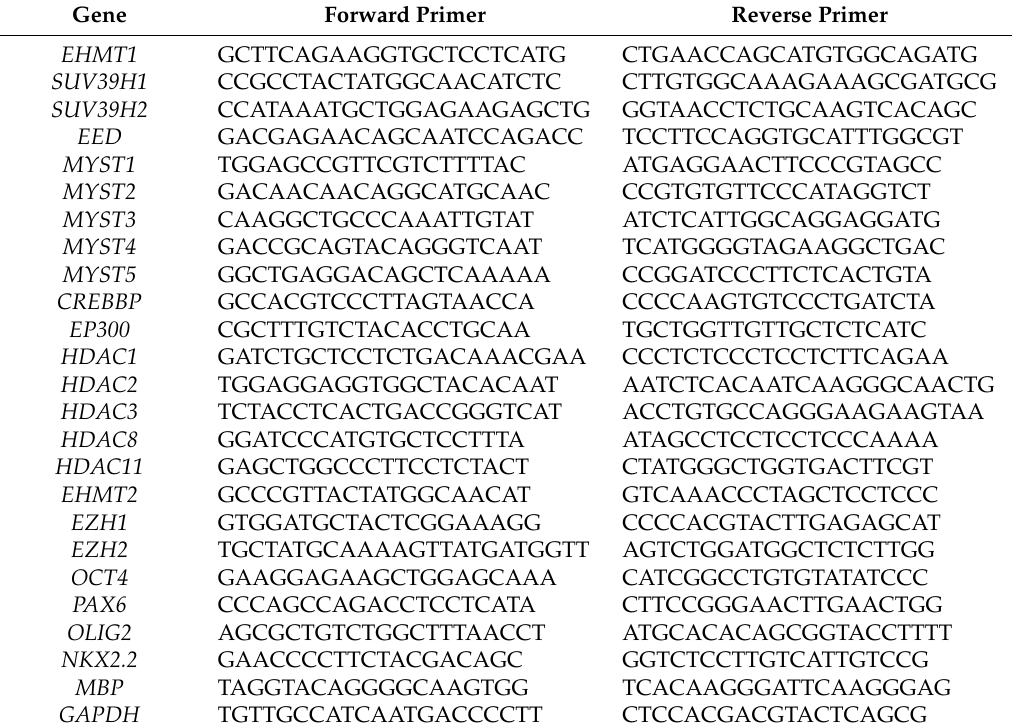
Table 1. List of primers used for qRT-PCR